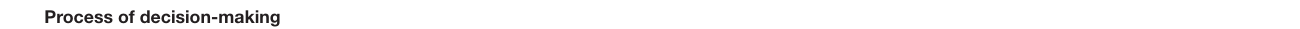
TABLE 4a | Trial decision-making and knowledge—Pre-DBS. Process of